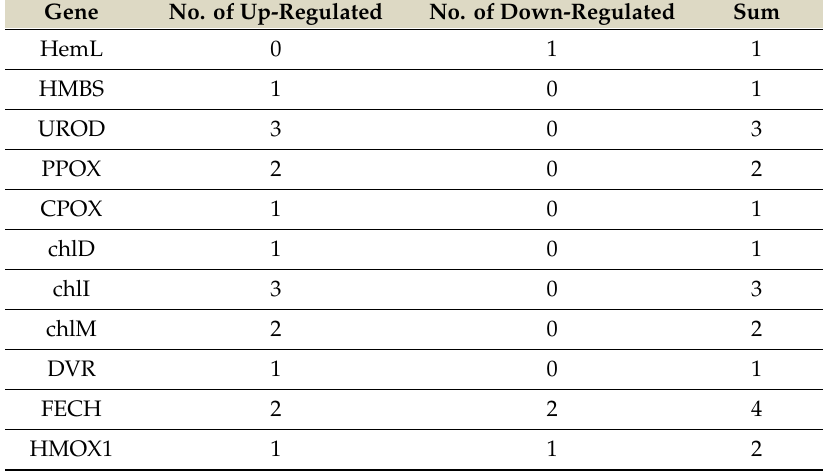
Table 3. Di ff erential expression genes related to Porphyrin and chlorophyll metabolism under TA treatment.